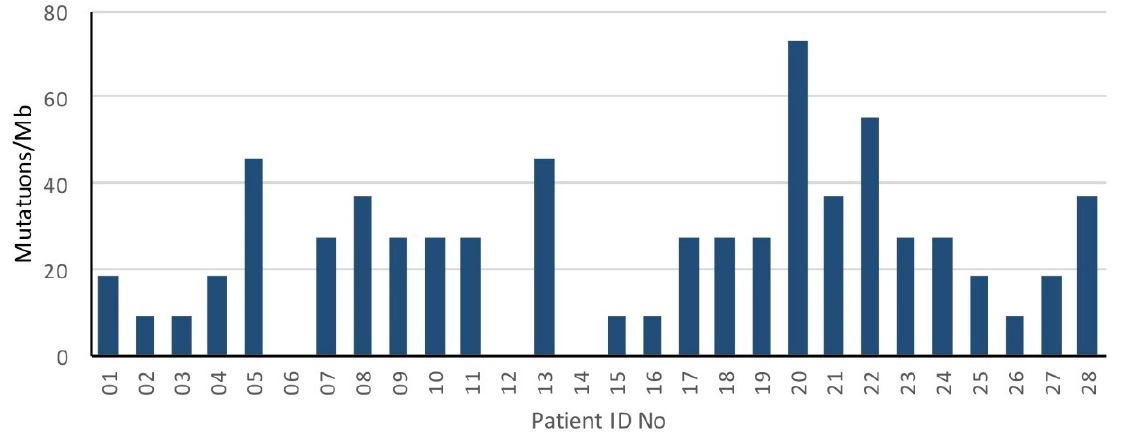
Figure 2. Genomic landscape of oligometastatic prostate cancer from targeted serum cfDNA se- quencing. Oncoprint shows genomic alterations identified in cfDNA of patients with oligometa- static prostate cancer. Genes are grouped by pathway (37 genes shown). Mutational frequency for each gene in the targeted panel is provided on the right. The median tumor mutational load was 27.5/Mb (range, 0–73.3 mutations/Mb) (Figure